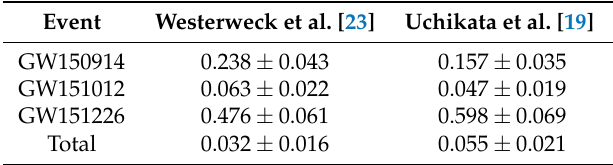
Table 7. p -values along with Poisson errors for O1 events [19].